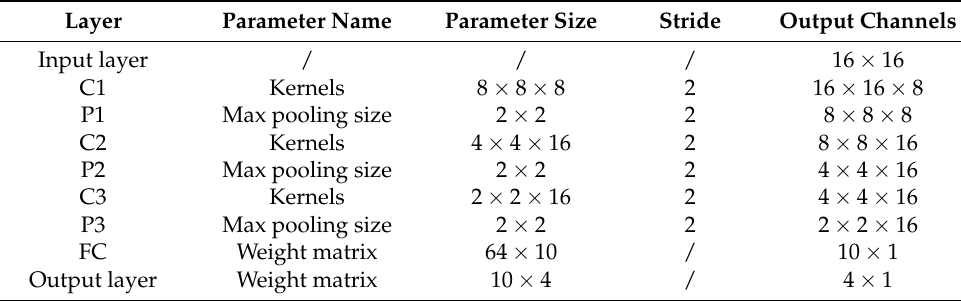
Table 1. A-HDCNN sub-model structure detailed parameter